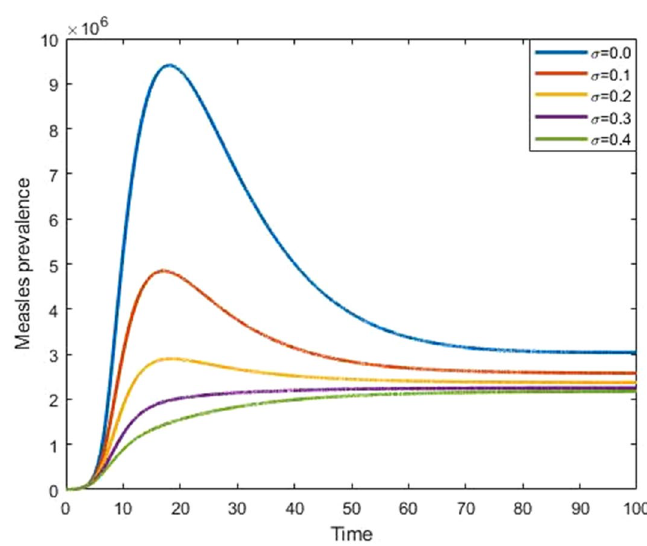
Figure 12. Impact of second dose vaccine ( σ ) on measles